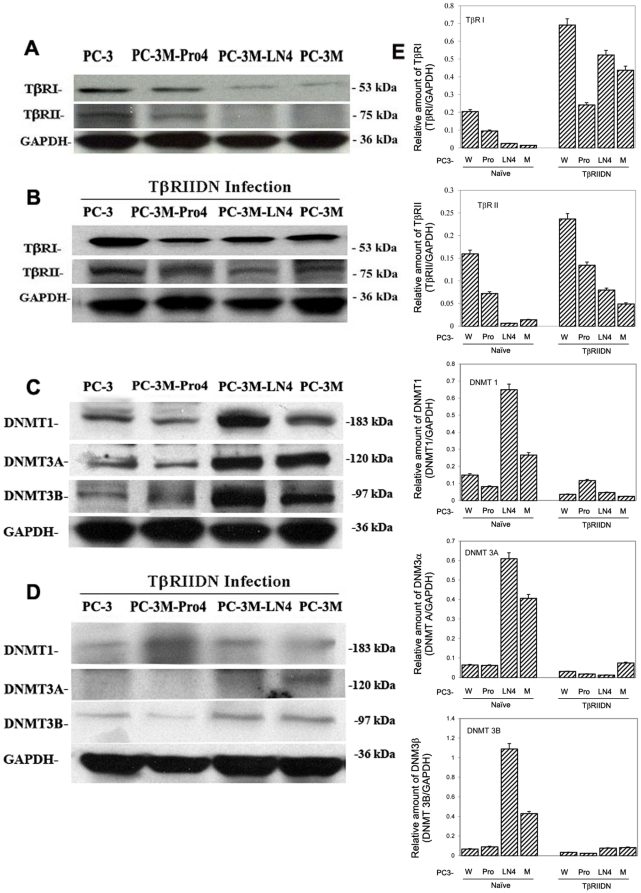
TGF-β induced expression of DNMTs is inversely associated with the expression of TβRs.
A. Western blot analyses demonstrate that in contrast to the expression of TGF-β, both TβRI and TβRII expression (as described in Figure 1B) is significantly reduced in the more invasive cell lines compared with less invasive cell lines. B. Blockade of TGF-β signaling with the TβRIIDN causes significant increase in the expression TβRIs in all cell lines. C. In contrast to the expression of TβRs, the over expression of DNMTs is associated with more invasive cell lines compared with the less invasive cell lines. D. Blockade of TGF-β signaling with TβRIIDN caused a ≥3-fold decrease in the expression of DNMTs. The corresponding value (relative ratio of TβRs/GAPDH, or DNMTs/GAPDH) is shown in right charts. (Fig. 2A and 2B were from the same Western Blot image, and Fig. 2C and 2D were from the other single Western blot image).